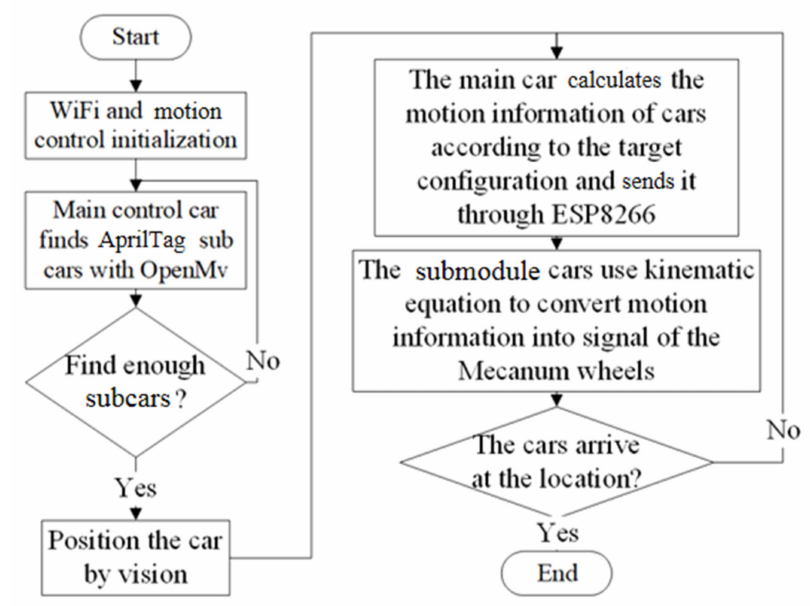
Figure 15. Reconfiguration methodology.